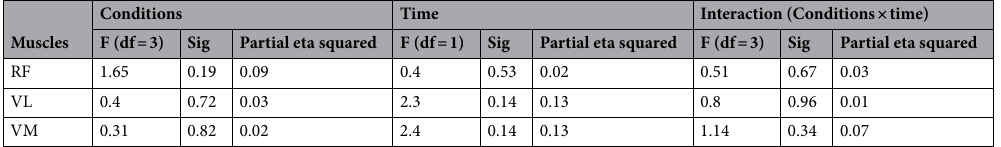
Table 2. Results of the two-way repeated measures ANOVA (muscle activity before and after fatigue during four different conditions). VM Vastus Medialis, RF Rectus Femoris, VL Vastus Lateralis.